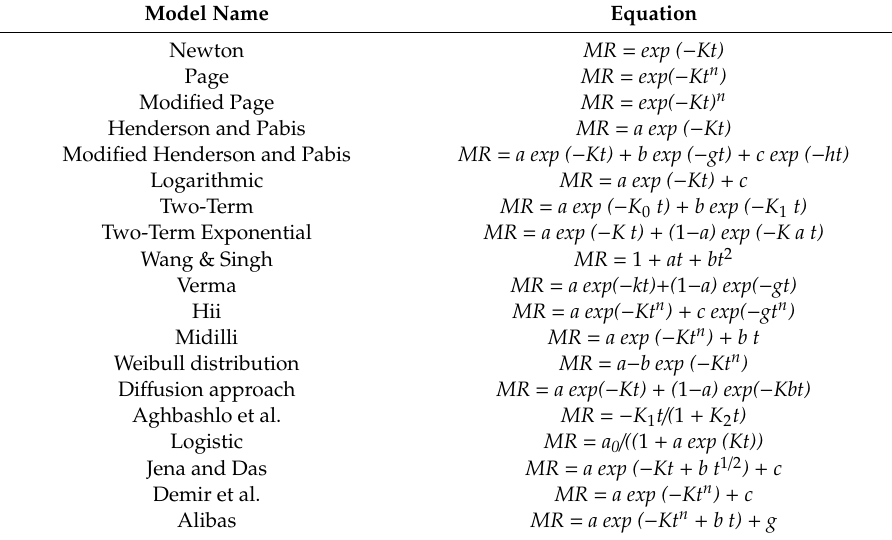
Table 1. Thin layer drying